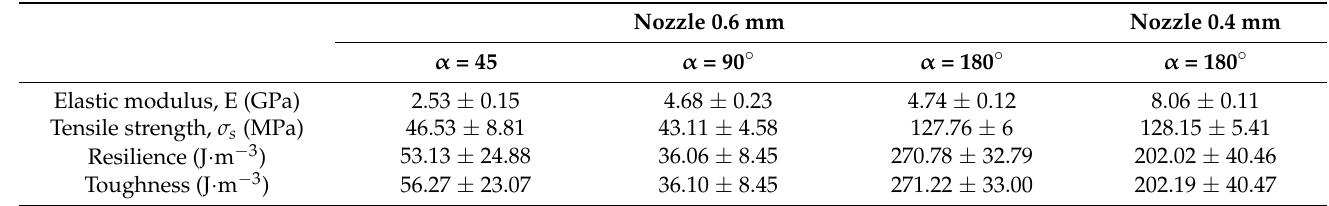
Table 3. Tensile properties of samples with heat treatment and filament infill angle α = 45 ◦ , α = 90 ◦ and α = 180 ◦